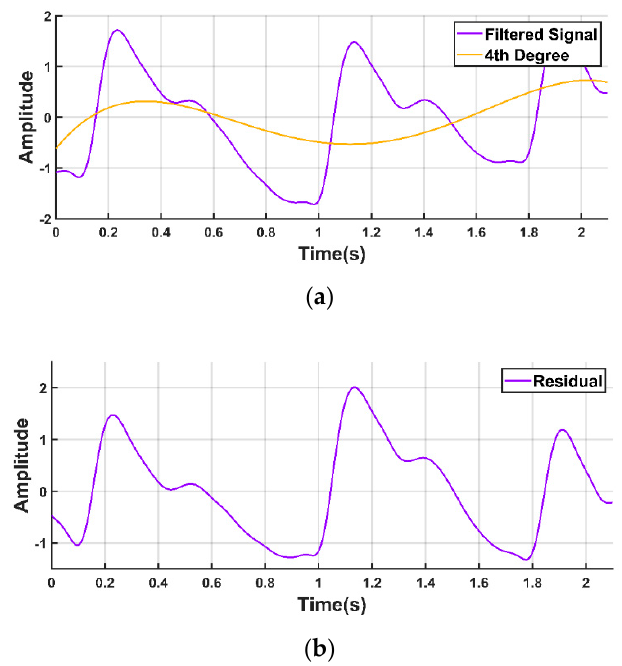
Figure 6. Baseline correction of PPG waveform. ( a ) PPG waveform with the baseline wandering and fourth degree polynomial trend; ( b ) PPG waveform after detrending.